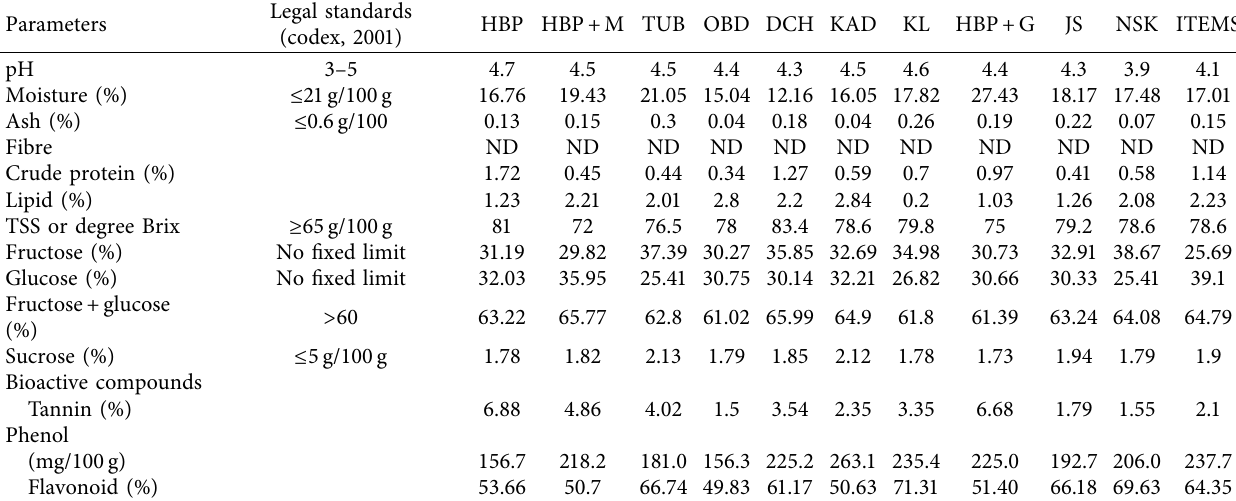
Table 3: Physiochemical parameters of honey